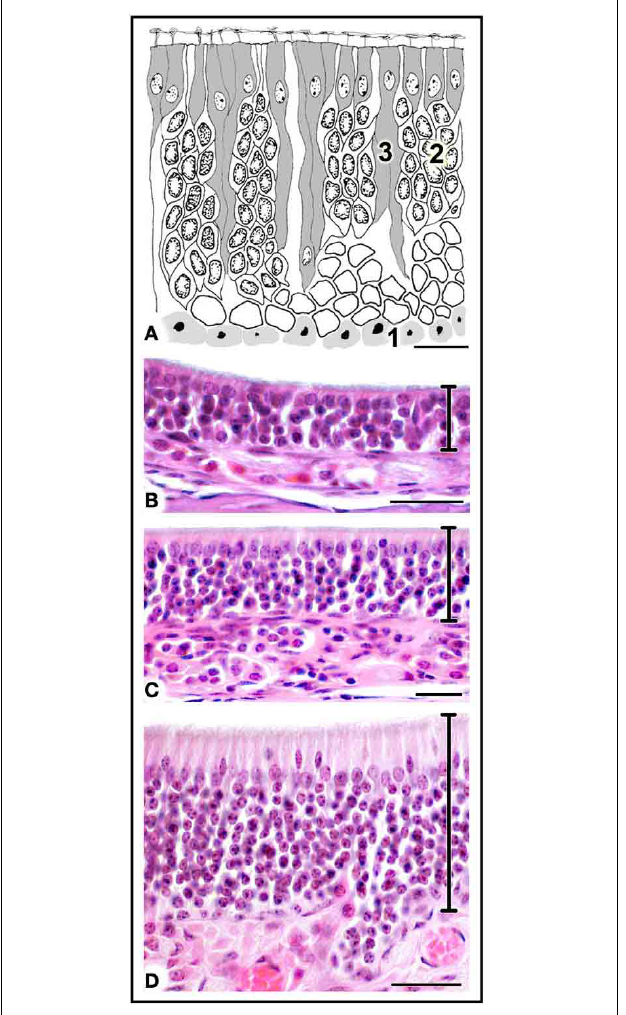
FIGURE 4 | (A) Diagrammatic reconstruction of main olfactory epithelium, showing basal cells (1), mature neurons (2) and supporting cells (3) (modified after Graziadei, 1971). (B,C) Haematoxylin-eosin-stained sections of areas of epithelium with different thicknesses (see text). Scale bars: (A) 10 μ m; (B) 20 μ m; (C,D) 25 μ m.